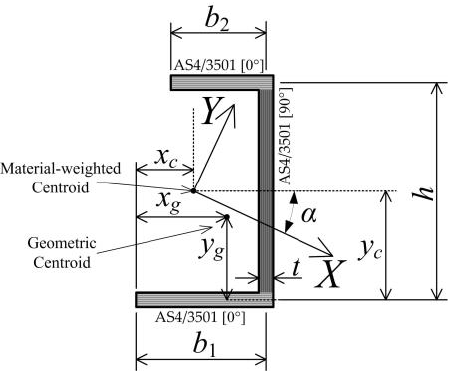
Figure 3. Cross-section geometry. Table 1. Cross-section properties of Examples 1 and 3.